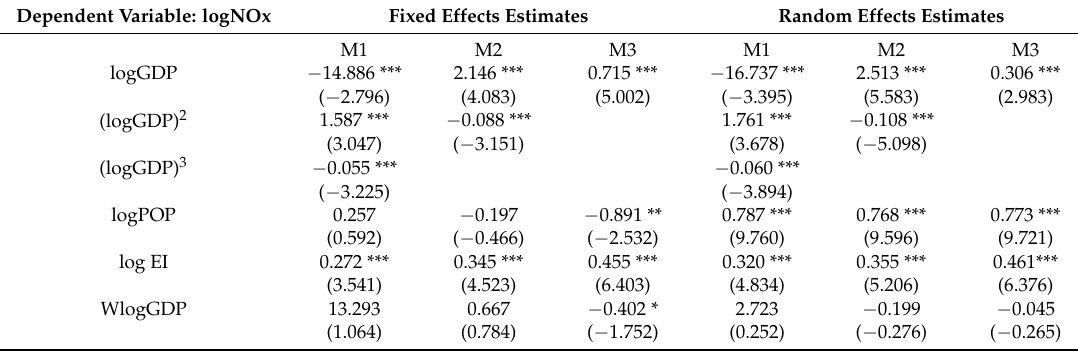
Table 4. Parameter estimates of the spatial panel model (GDP as the indicator of